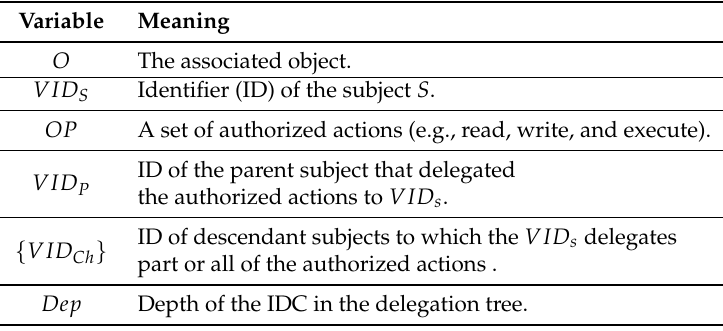
Table 1. Symbols in ICap and IDC